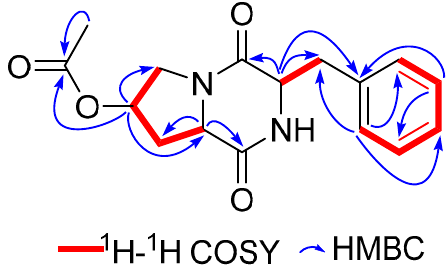
Figure 3. Key 1 H- 1 H COSY and HMBC correlations of compound 1 . Table 1. 1 H and 13 C NMR data of 1 in methanol- d 4 , (TMS, δ in ppm, J in Hz).